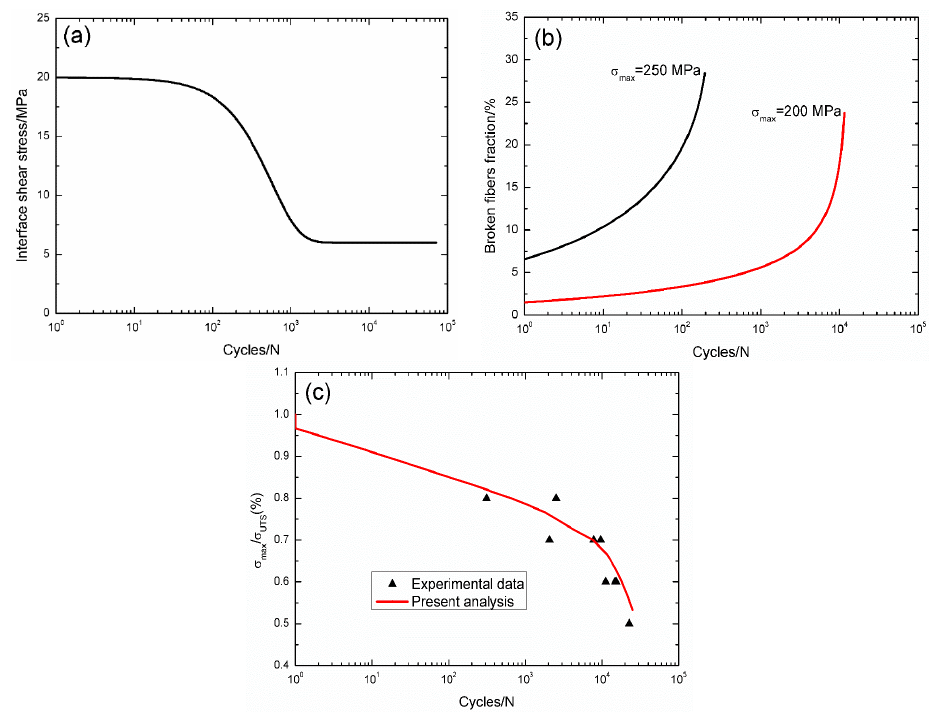
Figure 12. ( a ) The interface shear stress versus applied cycles; ( b ) the broken fiber fraction versus applied cycles; and ( c ) the fatigue life S–N curves of experimental data and theoretical analysis for 2D C/SiC composite at 1300 °C in the oxidative atmosphere.